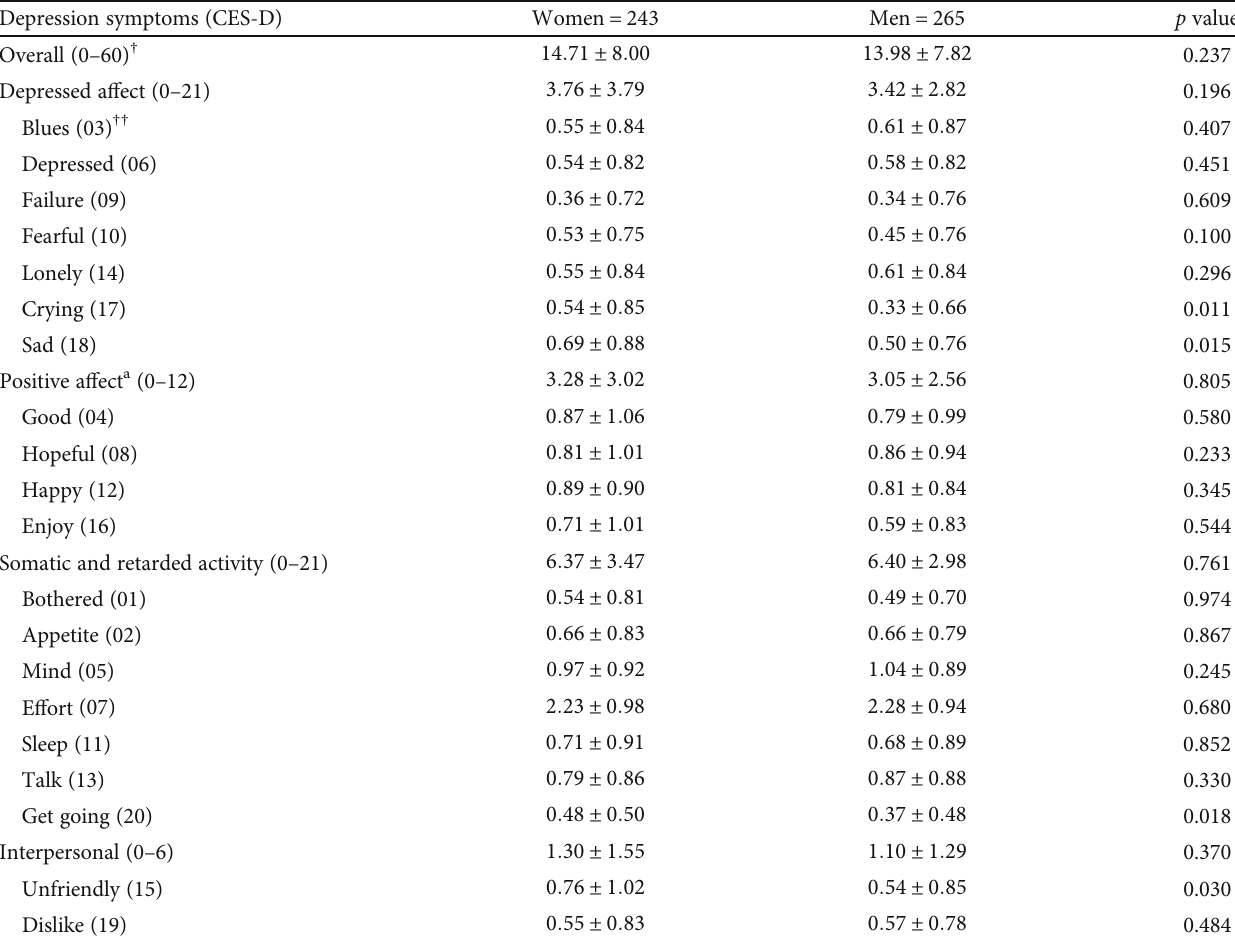
Table 2: Mean gender di ff erences in overall and four-factor depression